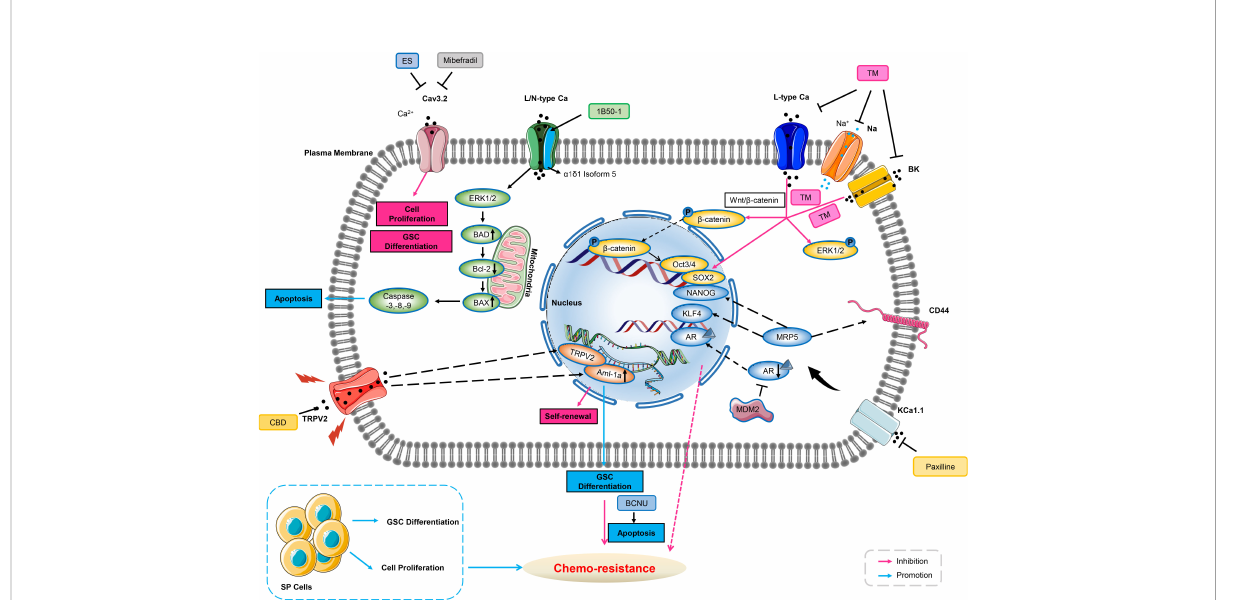
FIGURE 2 Ion channels involve in chemo-resistance through cancer stem cell. Blockade of Cav3.2 by either mibefradil or ES inhibits cell proliferation and GSC differentiation. 1B50-1 positive HCCs exhibits tumor-initiating cells property, treatment of the monoclonal antibody of 1B50-1 activates ERK1/2 signaling pathway to result in apoptosis of TICs, thus overcome chemo-resistance. Voltage-gated calcium channels, sodium channels, or BK channels are over-expressed in ovarian CSCs. TM inhibits these ion channels ’ currents, and reduces transcription factors of Oct3/4 and SOX2 via b -catenin signaling and ERK1/2 phosphorylation related to stemness and cell growth of ovarian CSCs, therefore abating chemo- resistance. Inhibition of KCa1.1 by its selective blocker of Paxilline can overcome antiandrogen acquired resistance due to MDM2 in human prostate cancer stem cells, meanwhile, this inhibition also overcomes acquired resistance of DOX due to MRP5 in LNCaP stem cells characterized with stemness markers of NANOG, CD44 and KLF4. CBD increases expression of AML-1a which subsequently binds to TRPV2 promoter to enhance transcription, and then induces GSCs differentiation, thus increasing the sensitivity to BCNU by triggering GSCs apoptosis. GSC, glioblastoma stem-like cells; ES, endostatin; Bcl-2, B-cell lymphoma-2; BAD, Bcl-2 associated death promoter; HCC, hepatocellular carcinoma; TICs, tumor-initiating cells; ERK1/2, extracellular regulated protein kinases1/2; DOX, doxorubicin; MRP, multidrug-associated protein; AR, androgen receptors; CBD, cannabidiol; AML, Acute myeloid leukemia; GSC, glioblastoma stem-like cells; BCNU, carmustine; MDM2, murine double minute